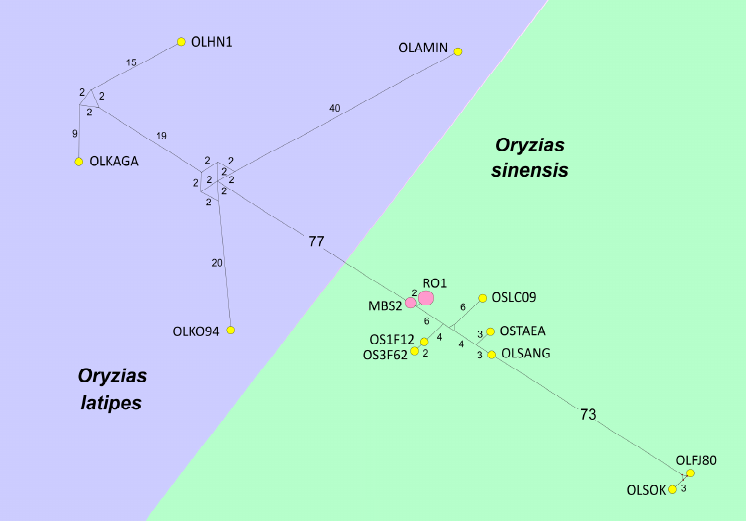
Figure 2. Median haplotype network of the COI gene sequence for fishes belonging to the genus Ozyrias . See Table 2 for sample designations and descriptions. The numbers on the lines reflect the numbers of nucleotide substitutions.